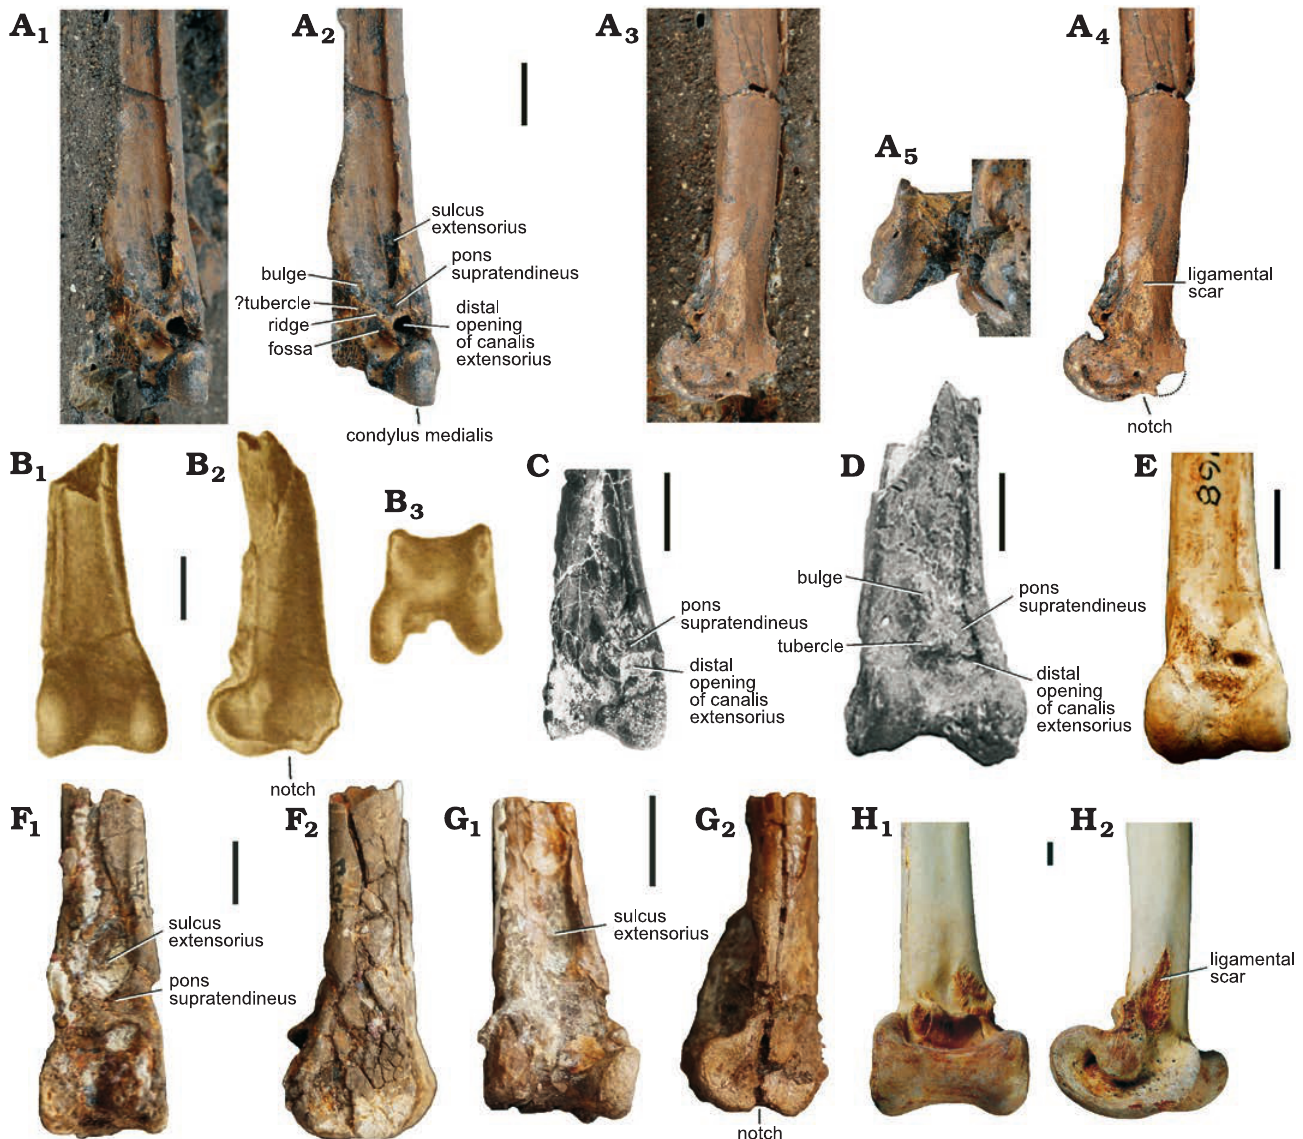
Fig. 2. Tibiotarsi of palaeotidid, geranoidid, eogruid, and struthionid birds. A . Palaeotis weigelti Lambrecht, 1928 (Palaeotididae) from the middle Eocene of the Geiseltal, Germany, GMH XXXVIII-6-1964; distal end of right tibiotarsus in cranial (A 1 , A 2 ), medial (A 3 , A 4 ), and distal (A 5 ) views; in A 2 and A 4 surrounding matrix was digitally removed, the dotted line in A 4 indicates the reconstructed outline of the missing caudal portion of the condy- lus medialis. B . Palaeogrus princeps Portis, 1885 (?Palaeotididae) from the middle Eocene of Italy; distal end of left tibiotarsus in cranial (B 1 ), medial (B 2 ), and distal (B 3 ) views (from Portis 1885; mirrored). C . Galligeranoides boriensis Bourdon, Mourer-Chauviré, and Laurent, 2016 (Palaeotididae) from the early Eocene of southern France, paratype: MHNT.PAL.2013.16.1; distal end of right tibiotarsus in cranial view (from Bourdon et al. 2016). D . G alligeranoides boriensis Bourdon, Mourer-Chauviré, and Laurent, 2016 from the early Eocene of southern France, holotype, MHNT.PAL.2013.16.3; distal end of right tibiotarsus in cranial view (from Bourdon et al. 2016; mirrored). E . Eogrus aeola Wetmore, 1934 (Eogruidae), AMNH 2946; distal end of right tibiotarsus in cranial view (mirrored). F . cf. Eogeranoides campivagus Cracraft, 1969 from the early Eocene of Wyoming, USA, AMNH 5127; distal end of right tibiotarsus in cranial (F 1 ) and medial (F 2 ) views (mirrored). G . Palaeophasianus meleagroides Shufeldt, 1913 (Geranoididae) from the early Eocene of Wyoming, USA, holotype, AMNH 5128; distal end of left tibiotarsus of in cranial (G 1 ) and medial (G 2 ) views (mirrored). H . Extant Struthio camelus Linnaeus, 1758 (Struthionidae), SMF 2438; distal end of right tibiotarsus in cranial (H 1 ) and medial (H 2 ) views. Scale bars 10 mm (for B scale is based on measurements in Portis